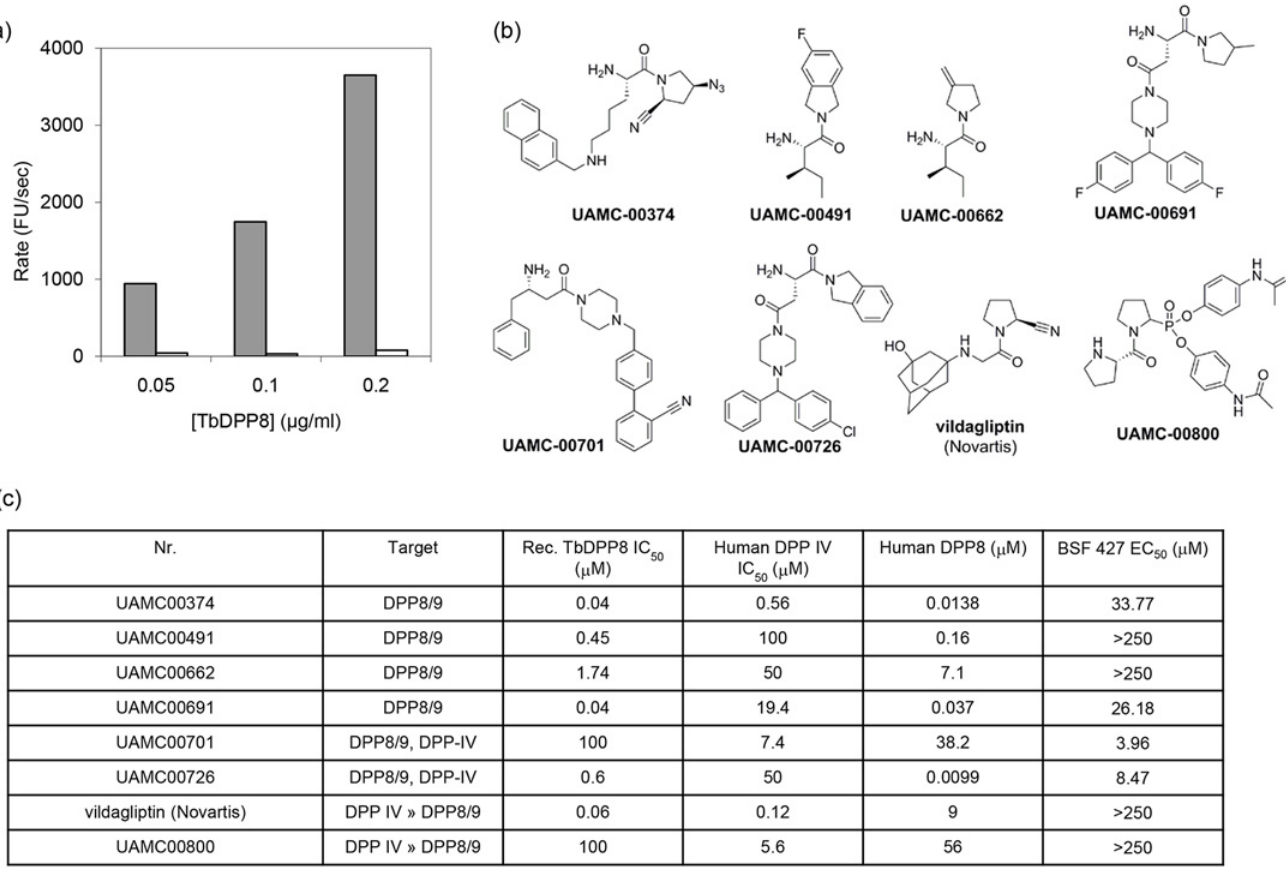
Fig 3. Recombinant TbDPP8 activity and inhibition. (a) Rate of cleavage by TbDPP8 of H-Gly-Pro-AMC (grey bars) and Z-Gly-Pro-AMC (white bars). (b) Structures of inhibitors used against TbDPP8. (c) Inhibitory activity of compounds against T . brucei DPP8, human DPP IV, human DPP8, and bloodstream form T . brucei